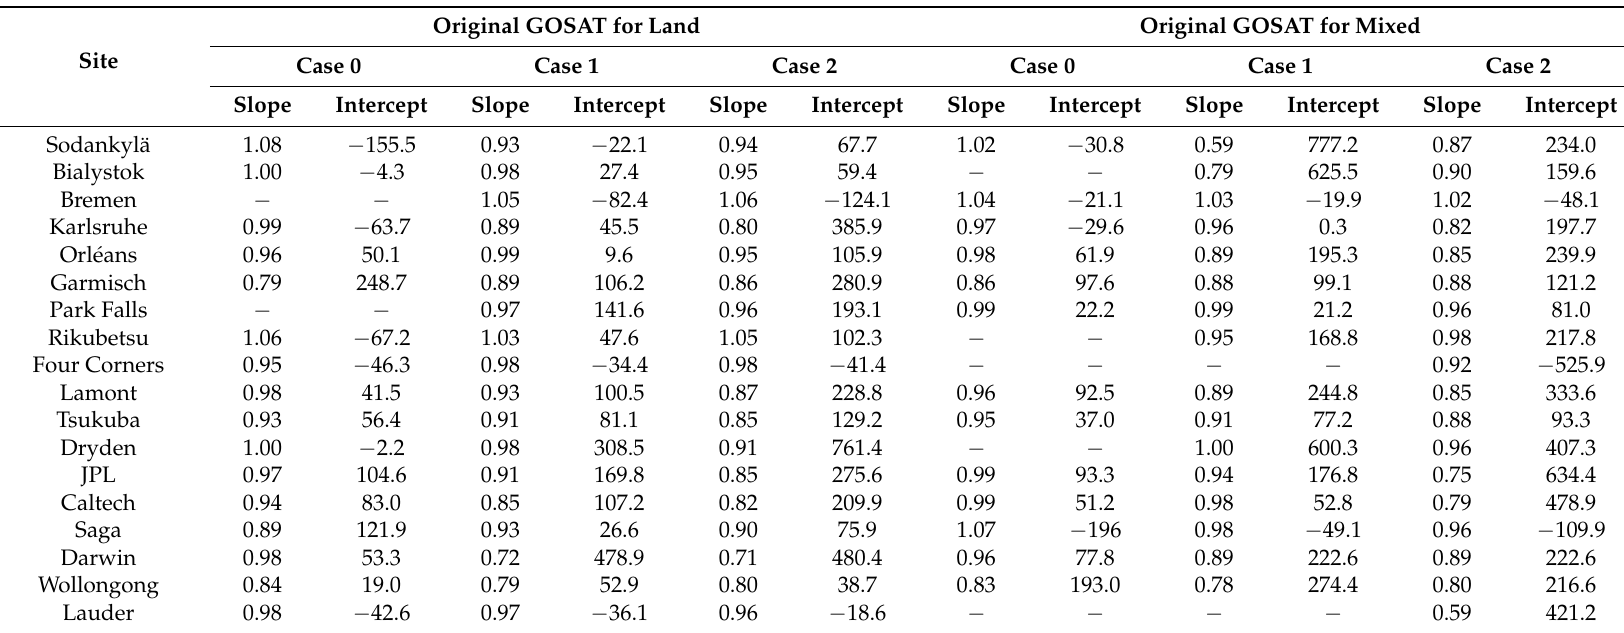
Table 3. Linear least-squares regression slope (ppm/ppm) and intercept (ppm) between original GOSAT SWIR XH 2 O and TCCON data for colocation cases 0, 1, and 2. Original GOSAT for Land Original GOSAT for Mixed Site Case